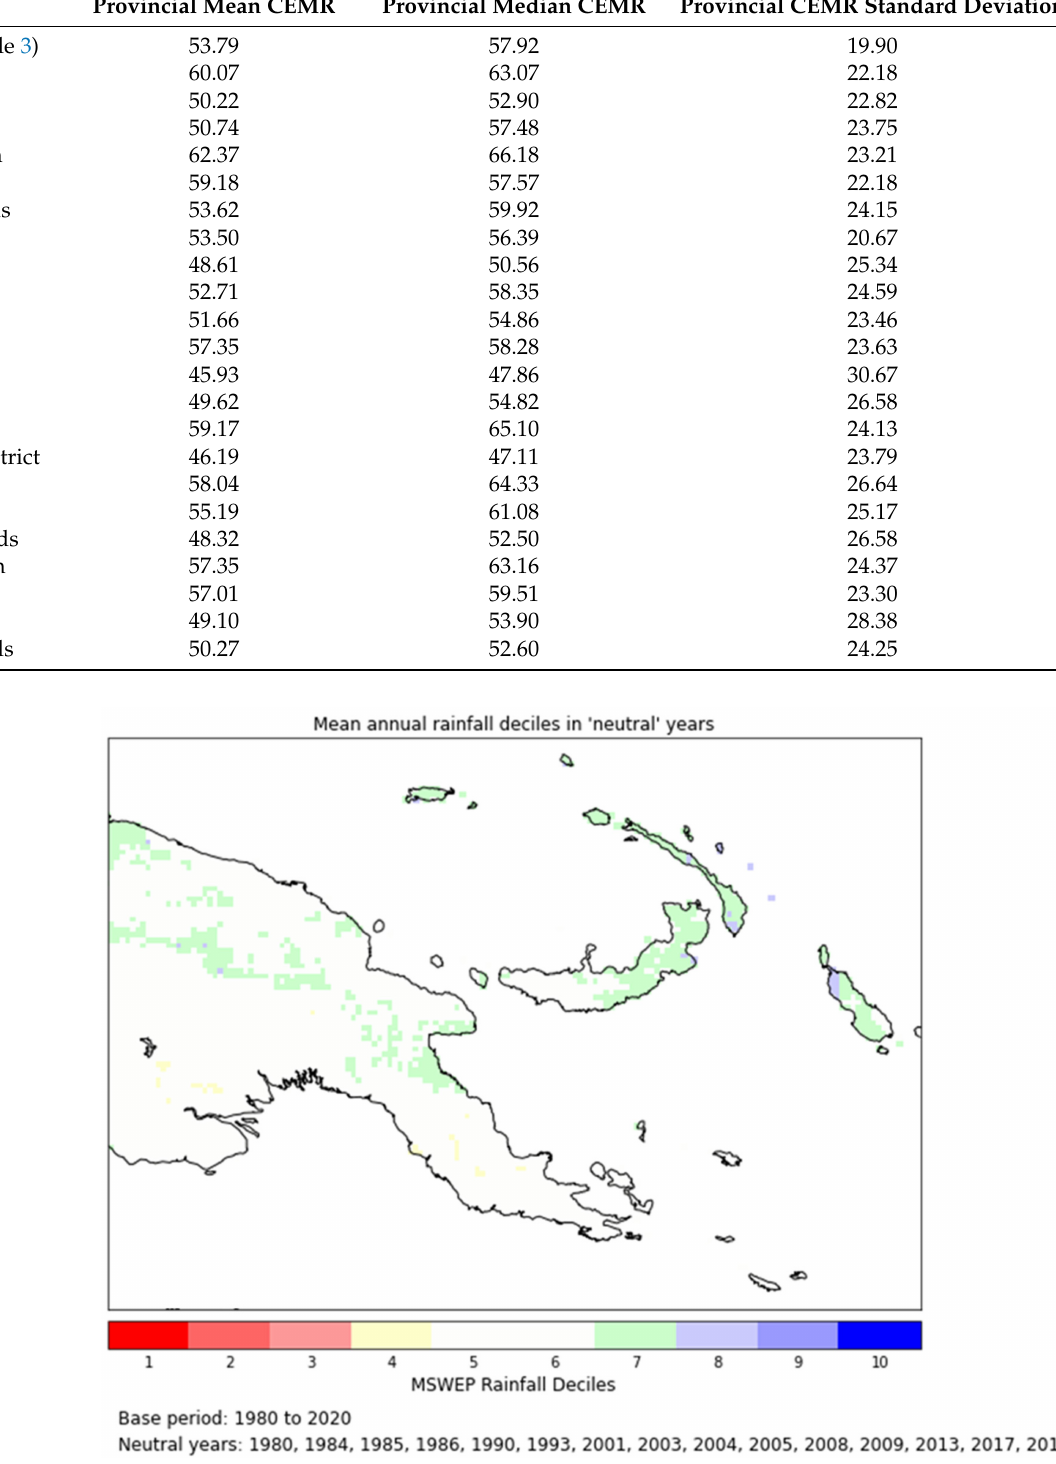
Figure A1. MSWEP rainfall deciles in “neutral” years (ENSO and IOD inactive